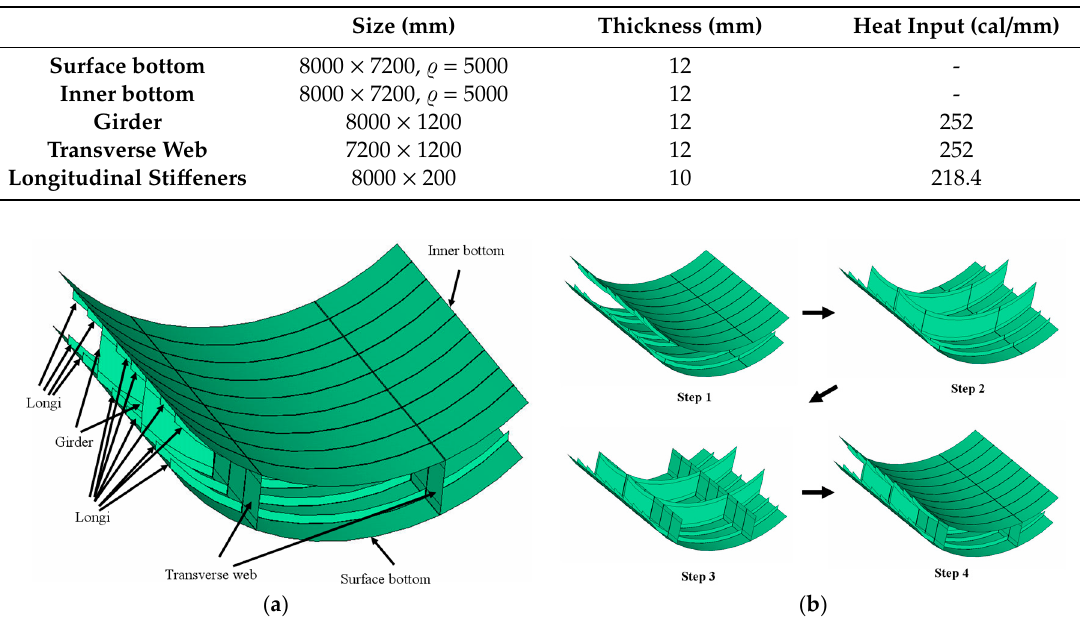
Figure 13. Analysis model: ( a ) curved double bottom block, ( b ) welding sequence.